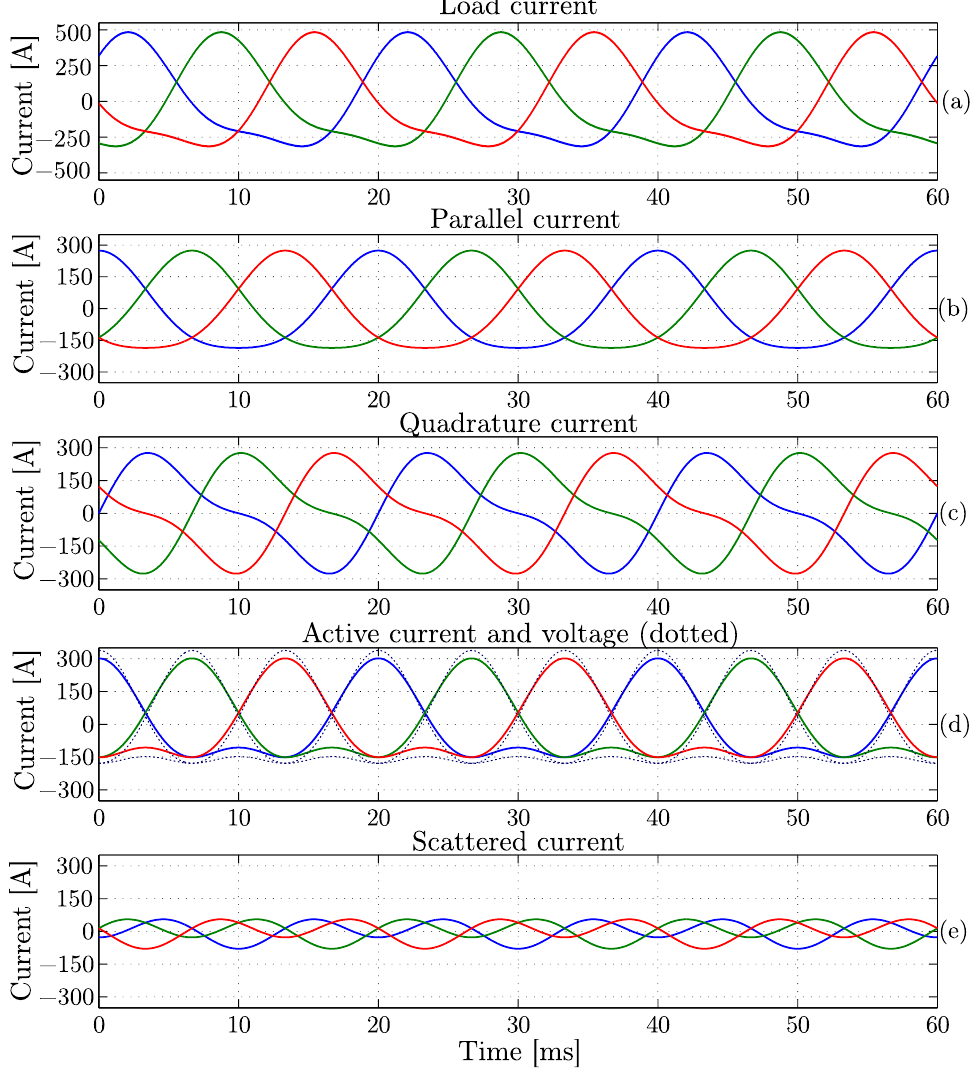
Figure 7. Voltage and current waveforms for Example 2. ( a ) Load current, ( b ) parallel current, ( c ) quadrature current, ( d ) active current and voltage, and ( e ) scattered